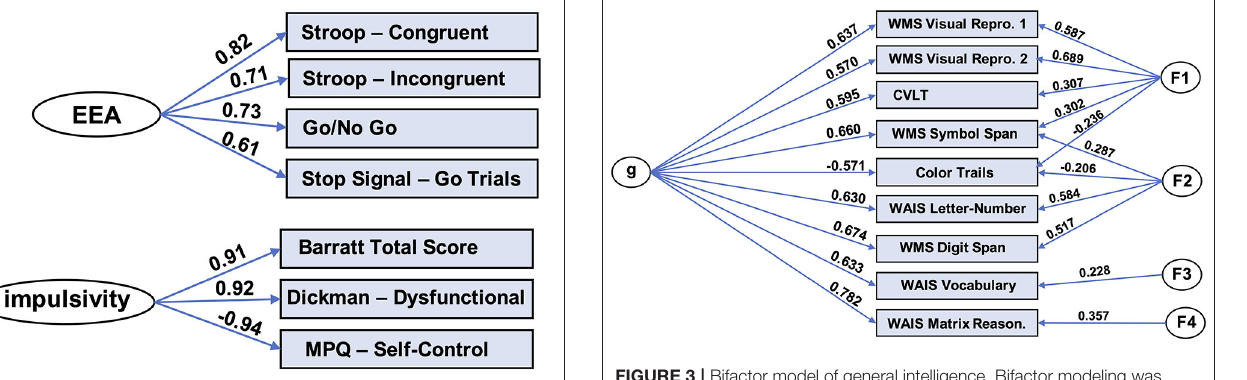
FIGURE 2 | Factor models for EEA and impulsivity. Factor analysis yielded latent variables for efficiency of evidence accumulation (EEA) and impulsivity. MPQ, Multidimensional Personality Questionnaire.